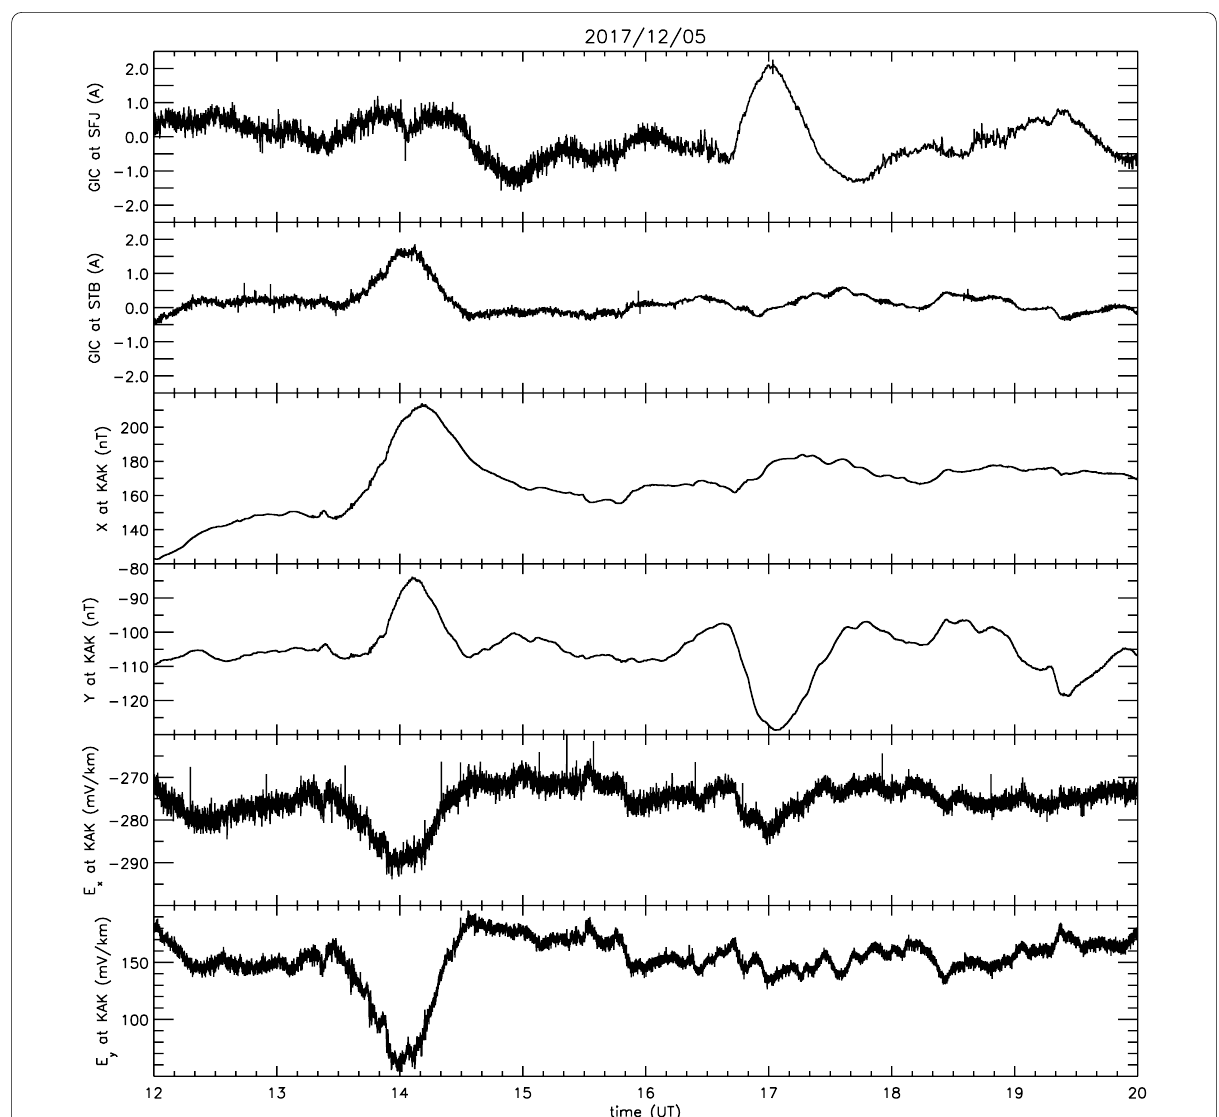
Fig. 8 GIC at SFJ and STB, and X- and Y-components of geomagnetic and geoelectric fields at KAK associated with bay disturbances on 5 December